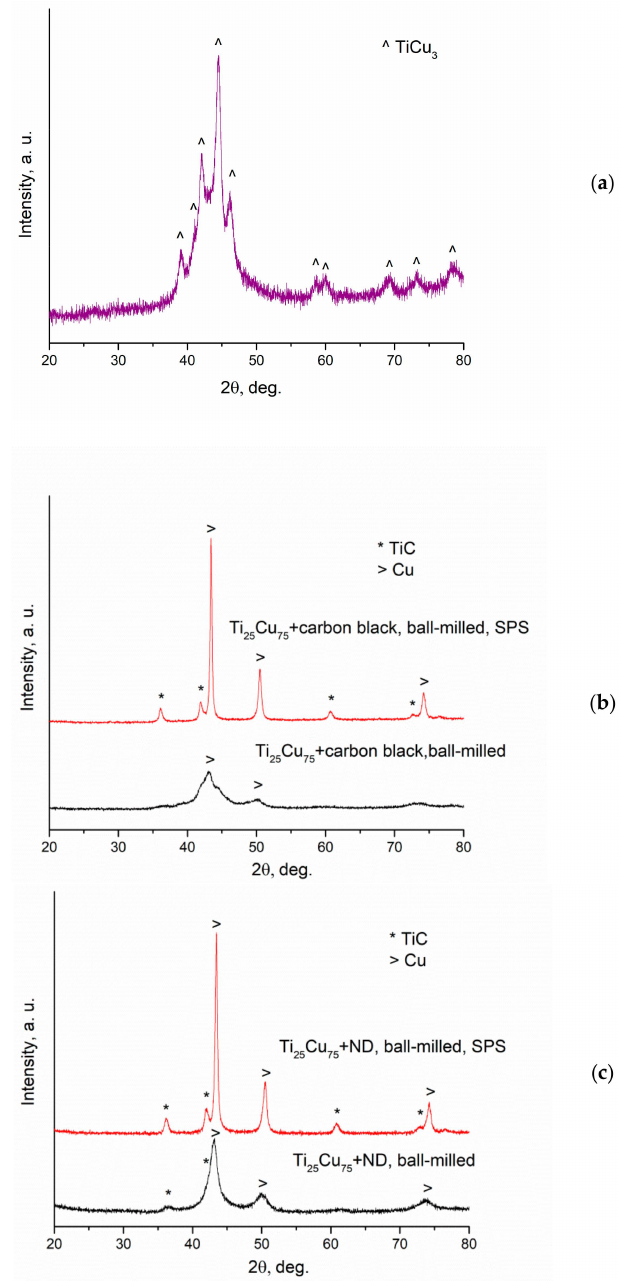
Figure 3. X-ray di ff raction (XRD) patterns of the Ti 25 Cu 75 alloy ribbon (TiCu 3 PDF card 00-025-316) ( a ); reaction mixture obtained by ball milling of Ti 25 Cu 75 with carbon black and sintered composite ( b ); reaction mixture obtained by ball milling of Ti 25 Cu 75 with nanodiamonds (coarse fraction separated) and sintered composite ( c